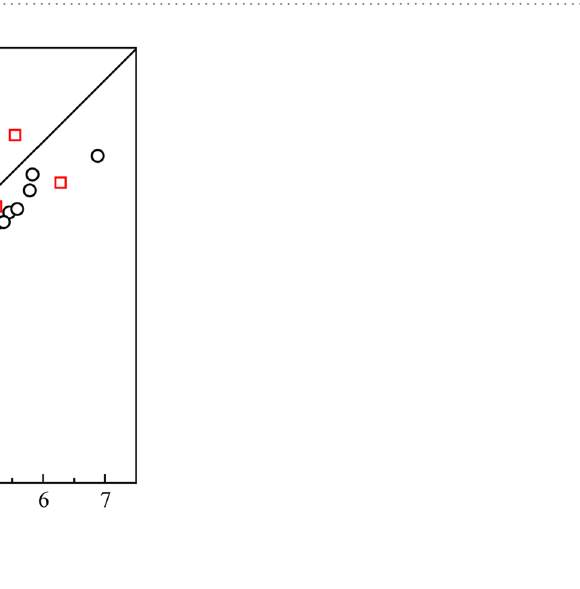
Figure 3. Plot of the − logC values predicted by the SVM model ( − logCp) vs. those observed ( −